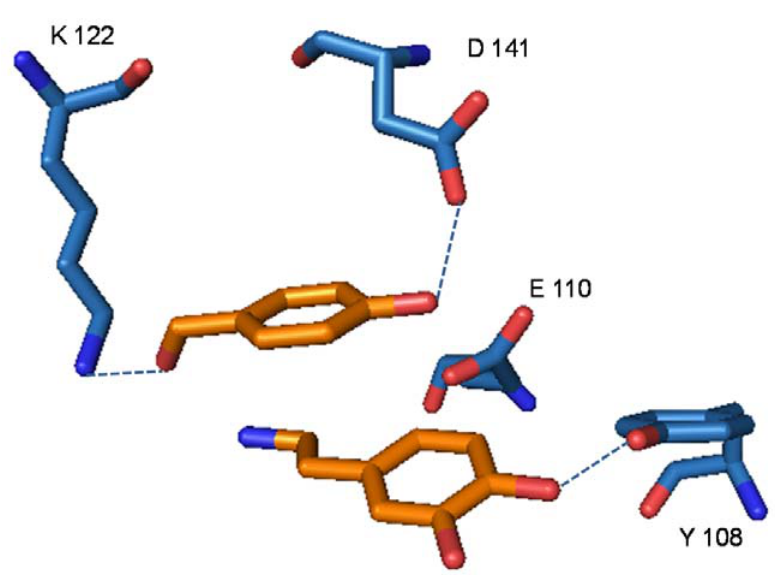
Figure 1. Amino acid residues involved in NCS